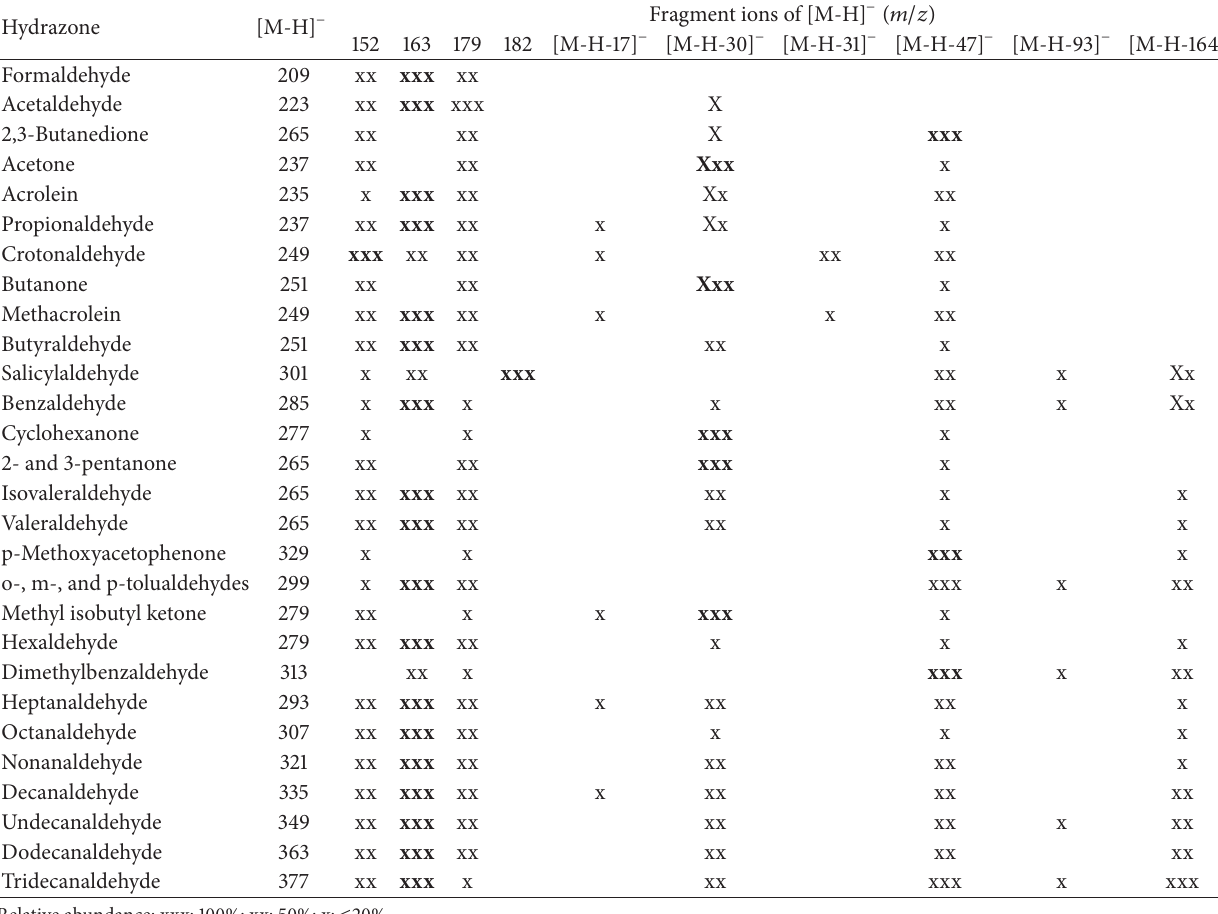
Table 3: Major fragments ( 𝑚/𝑧 ) of MS 2 spectrum formed by fragmentation of the precursor [M-H] − ions of the hydrazones. Hydrazone